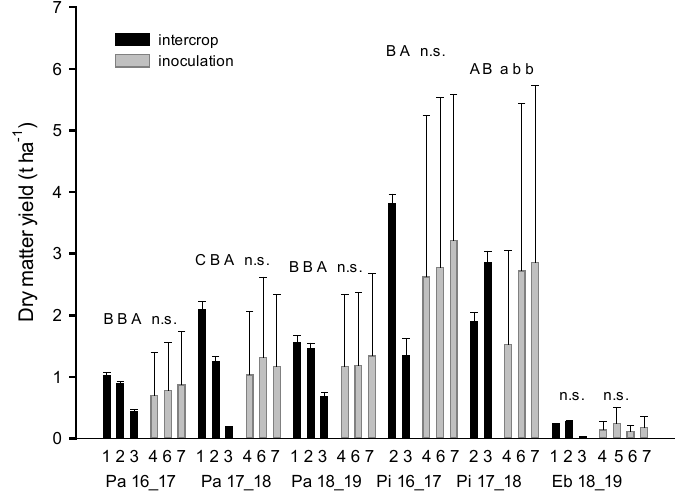
Figure 1. Shoot dry matter yield intercrops. Values followed by different letters are significantly different at LSD 5%. In this context, each site and the type of intercrop as well as inoculation was considered separately. Bars indicate the standard error (SE). Large letters indicate significant differences between the different intercrops, small letters between the inoculation variants. n.s. = not significant; Pa = Pawlowice; Pi = Pillnitz; Eb = Ebersbach; 1 = buckwheat; 2 = buckwheat/soybean; 3 = soybean; 4 = uninoculated/uninoculated; 5 = uninoculated/inoculated; 6 = inoculated/uninoculated; 7 = inoculated/inoculated.